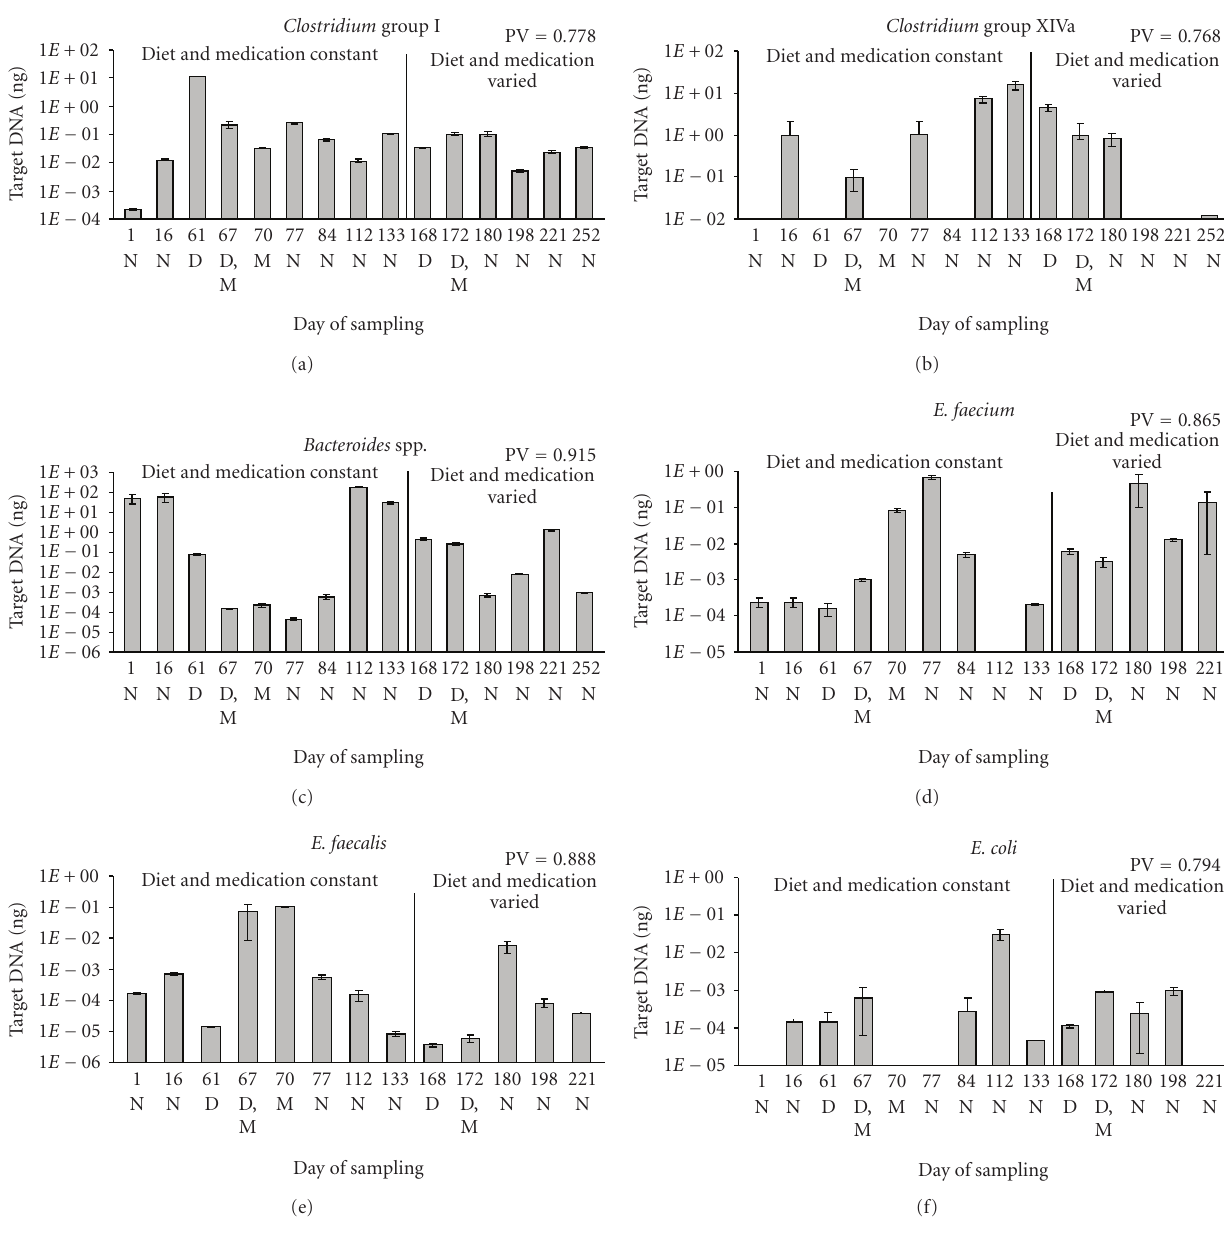
Figure 5: Q-PCR analysis of bacterial groups in fecal samples from a single pet with two diarrheic episodes . Panel (a) Clostridium group I; Panel (b) Clostridium group XIVa; Panel (c) Bacteroides spp.; Panel (d) E. coli ; Panel (e) E. faecium ; Panel (f) E. faecalis . R 2 values for the standard curves were 0.995, 0.986, 0.956, 0.958, 0.980, and 0.998, respectively. Error bars indicate the standard deviation of triplicate samples. Lack of a bar indicates that no product was detected in 40 cycles. The sample for day 252 was exhausted before Q-PCR for E. faecium, E. faecalis, and E. coli was performed. Population variability (PV) values are shown at the upper right of each